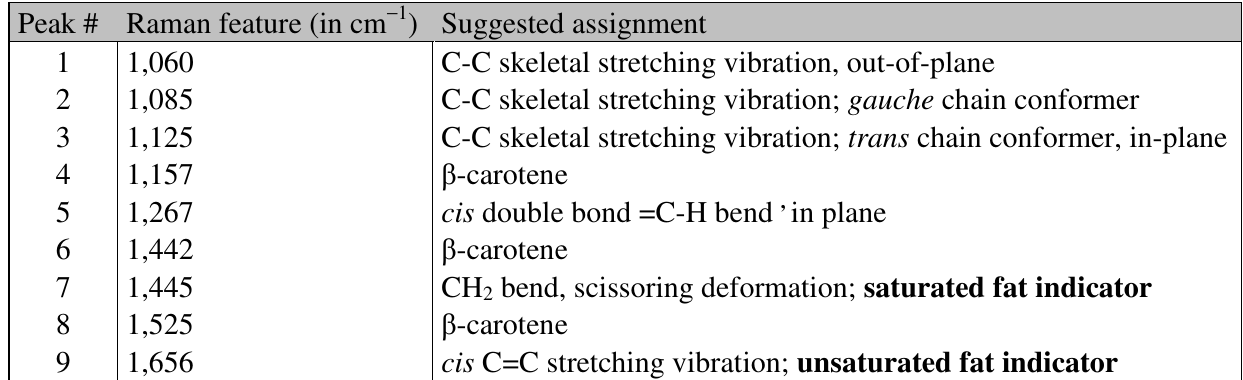
Table 1. Summary of the most prominent peaks / bands observed in the Raman spectra of algae, together with suggested assignments of vibration modes and contributing chemical compounds. Peak numbers of the table are used to identify features in the spectra shown in Figure